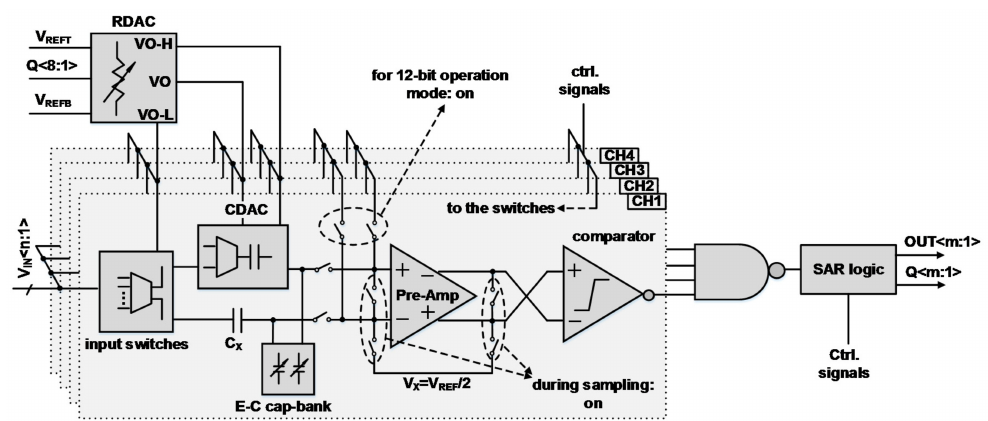
Figure 2. Block diagram of the proposed multi–channel hybrid-type successive approximation register (SAR)